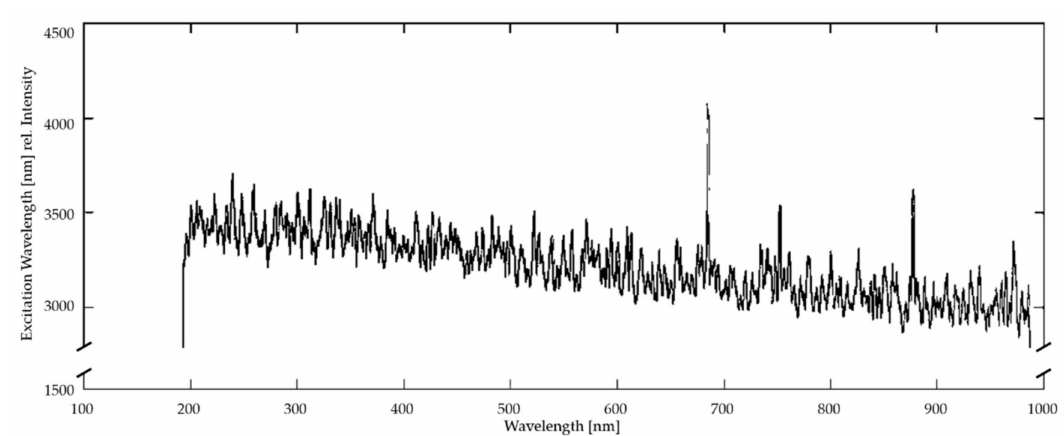
Figure A1. Dark counts of the ‘Kallemeter’ fluorescence detection spectrometer, measured by a long-term in situ test of 50 full EEM spectra (presented as an overlay) over a period of 116 h exhibiting a constant slight intensity gradient against the ordinate (wavelength).